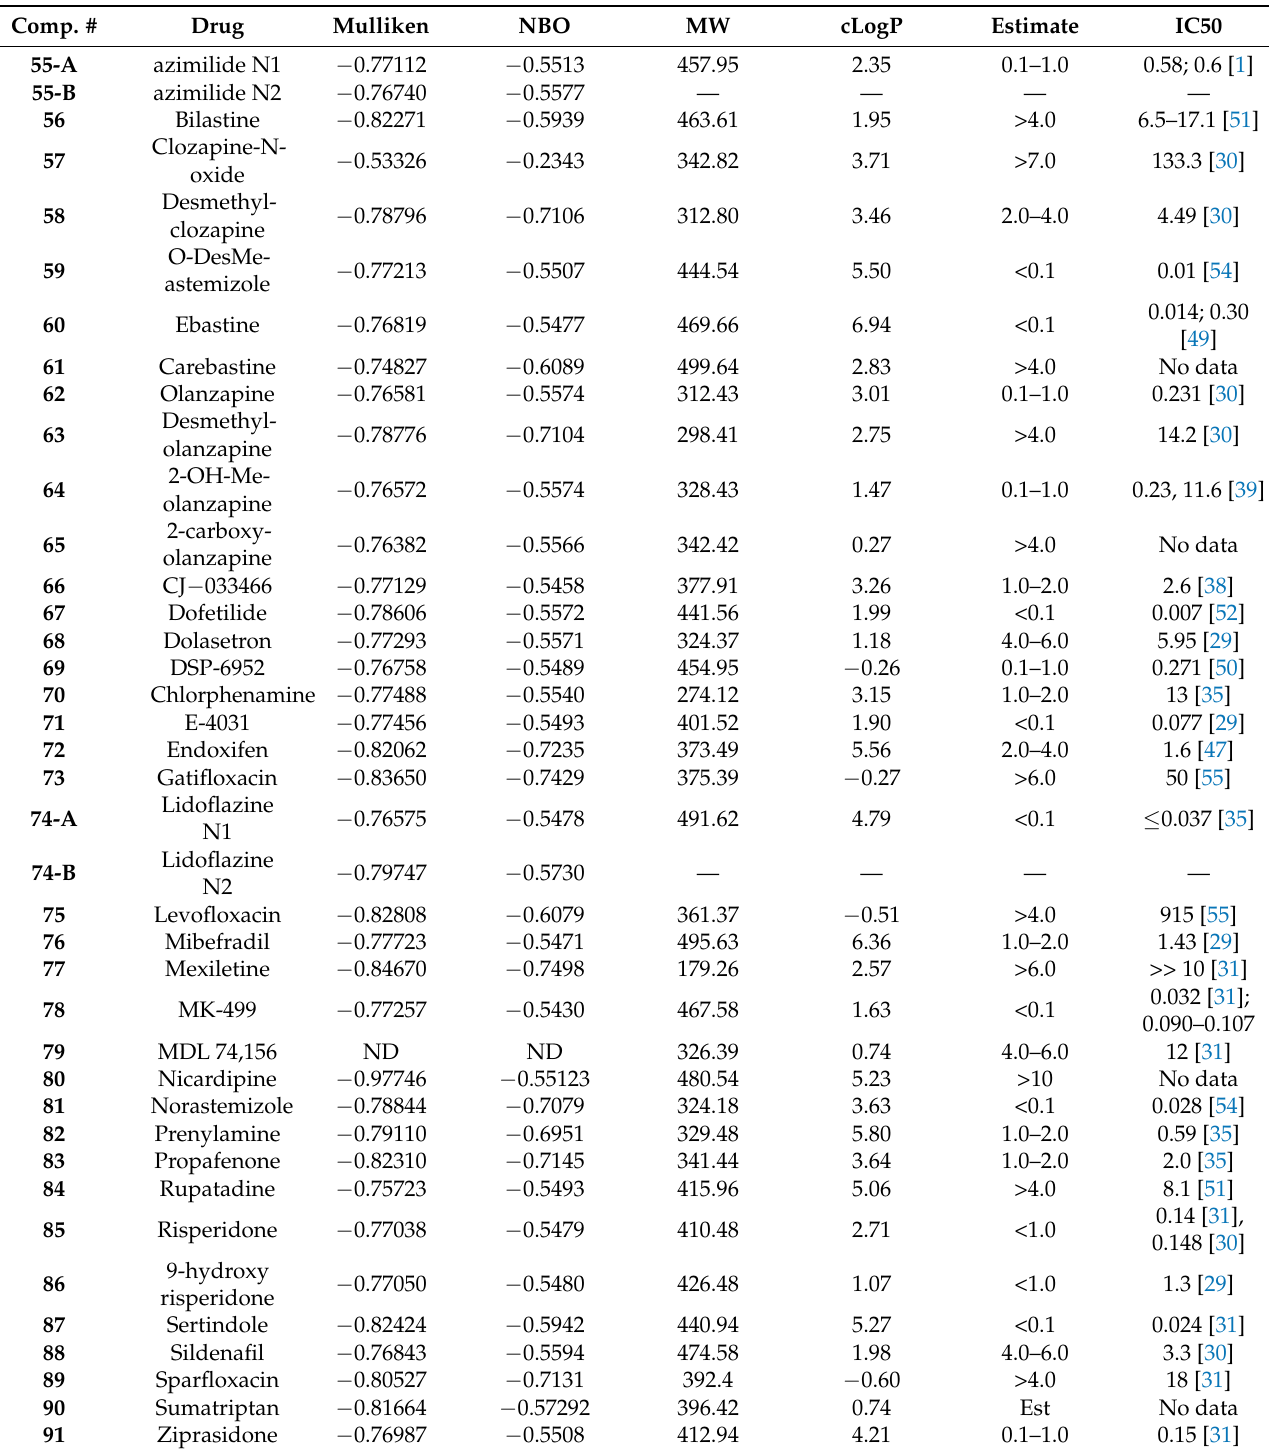
Table 4. Computational analysis using ab initio HF/321G, Mulliken, NBO, molecular weight, and cLogP of protonated drug compound set two.